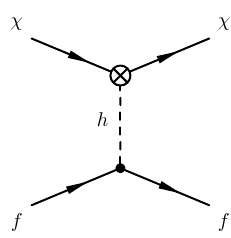
Figure 1 . Matching contributions to dimension-seven e(cid:11)ective operators for (cid:22) < v EW due to Higgs